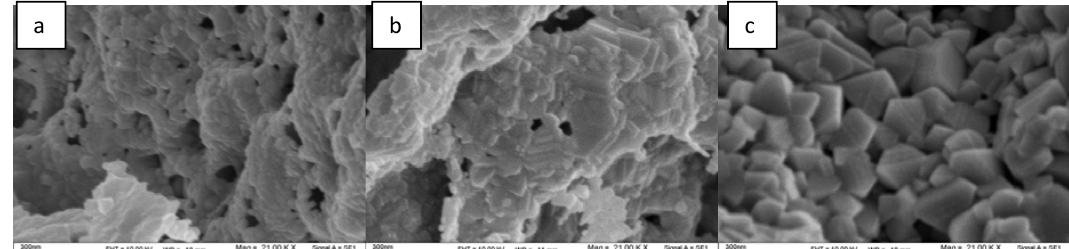
O samples: a)CuFe 2 4